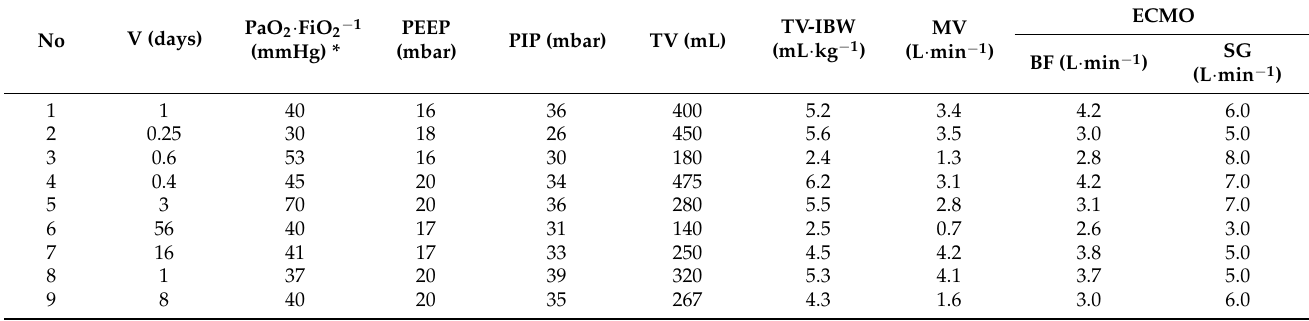
Table 2. Respiratory parameters at the time of first breath gas analysis.